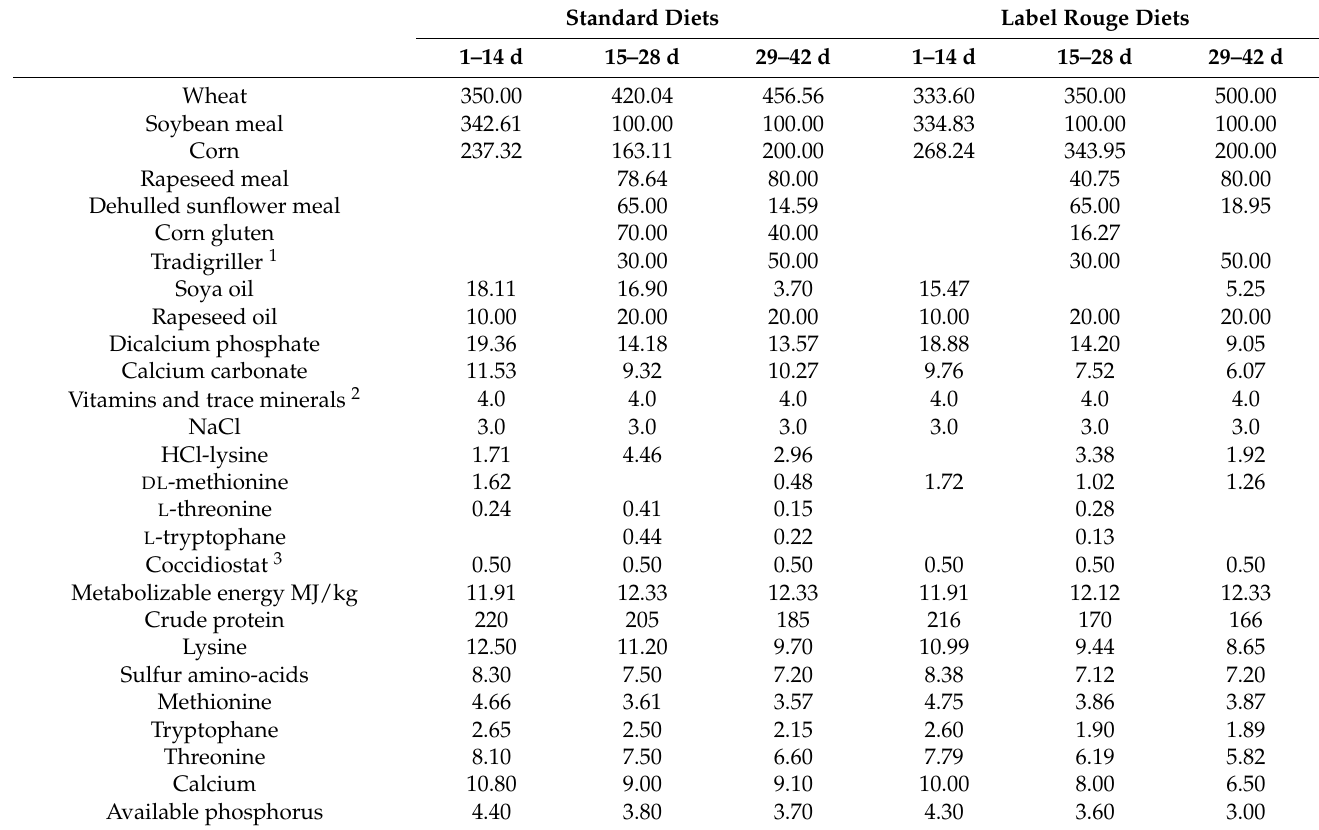
Table 1. Composition and main calculated characteristics (g/kg) of